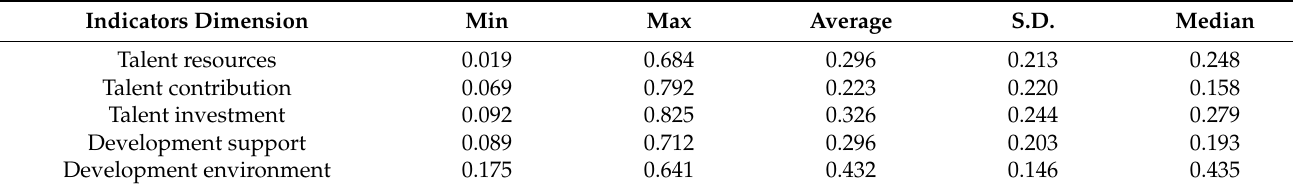
Table 8. Index analysis of talent competitiveness of the intelligent industry in nine provinces and